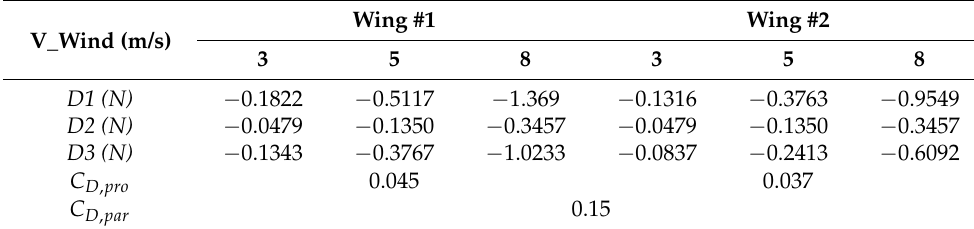
Figure 8. Using AOA = 15°, f = 3.5 Hz, and V_wing = 5 m/s: (a) lift measured by modeling and experiment, and thrust measured by experiment; (b) power comparison of the model and experimental results. Table 2. Data for drag coefficient calculation.